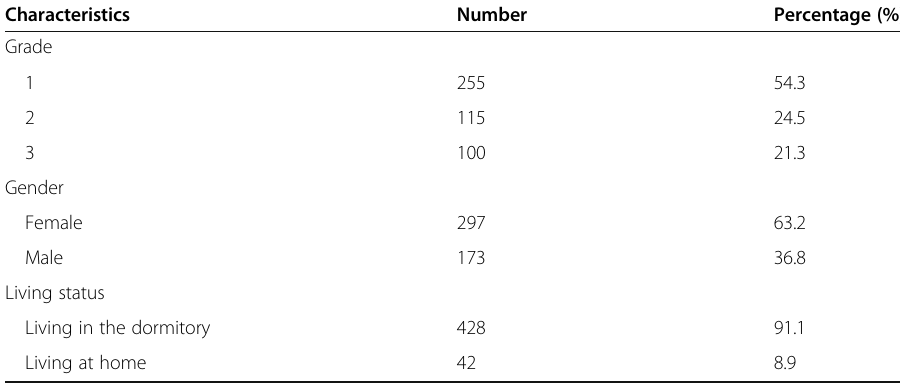
Table 3 Demographic characteristics of the participants